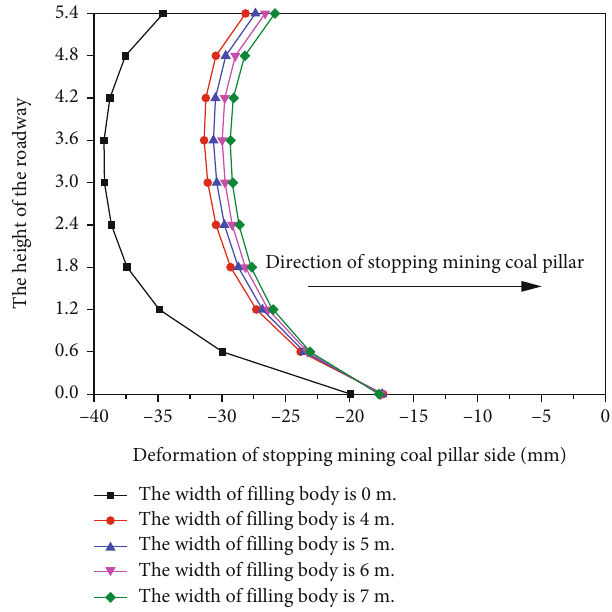
Figure 13: The deformation of the coal wall at the side of the stopping mining coal pillar in the auxiliary main haulage roadway.